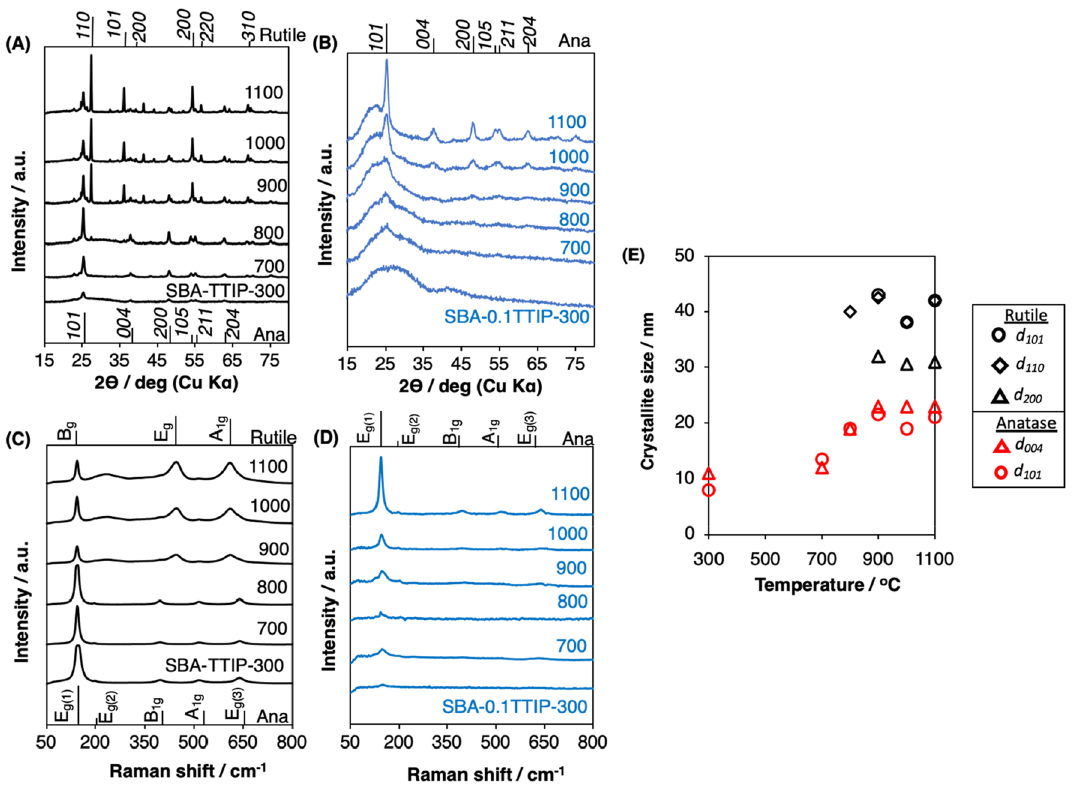
Figure 5. X-Ray powder diffraction patterns of the heated ( A ) SBA-TTIPs and ( B ) SBA-0.1TTIPs, Raman spectra of the heated ( C ) SBA-TTIPs and ( D ) SBA-0.1TTIPs (Ana shorted from Anatase) and crystallite size of titania in ( E ) SBA-TTIPs after the heat treatment at designed